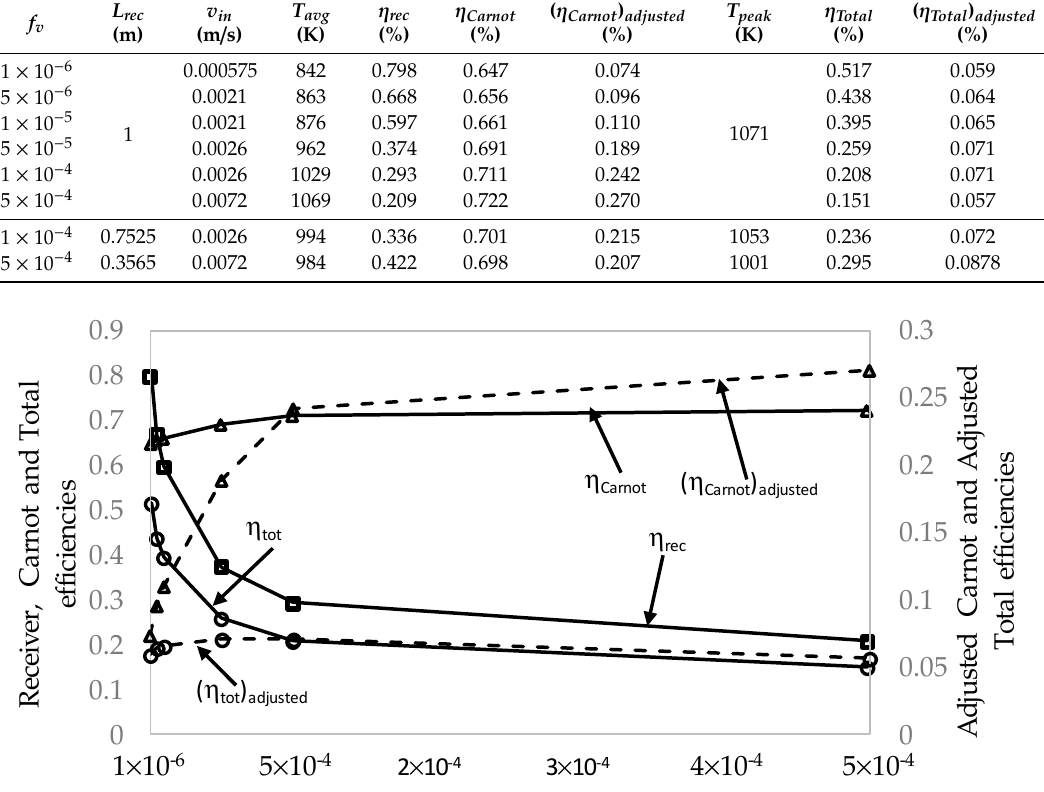
Table 3. Receiver results of each volume fraction at the maximum receiver length (first six rows) and maximum adjusted total efficiency (first four rows + last two rows).